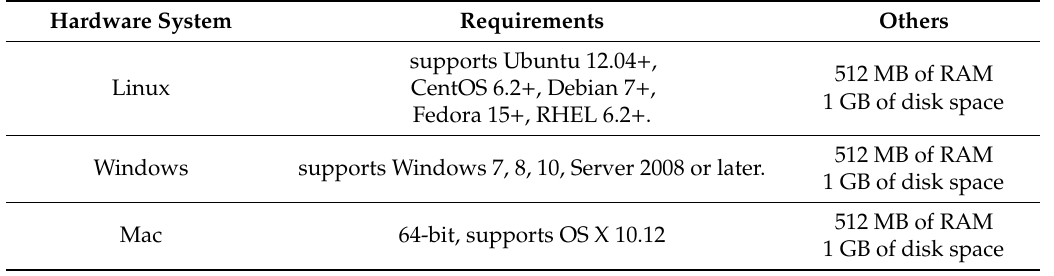
Table A2. Specifications required for blockchain